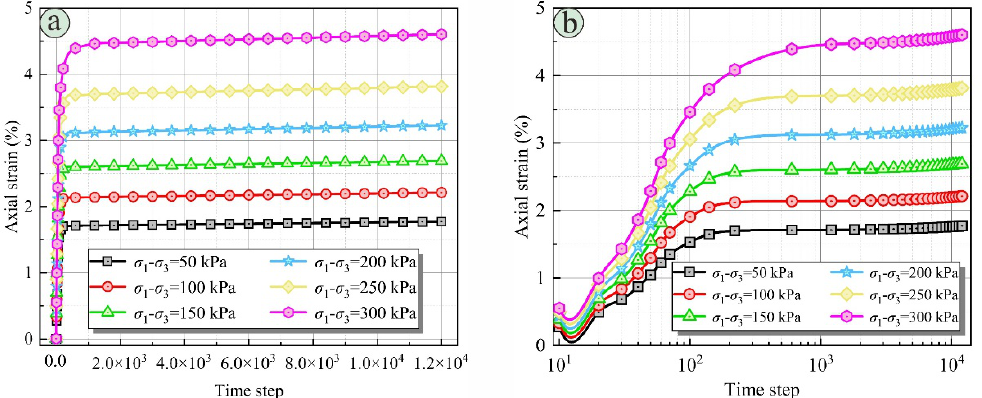
Figure 9. Variation of axial strain with time step: ( a ) Axial strain time step curve under different deviatoric stresses; ( b ) Axial strain time step semi logarithmic curve under different deviatoric stresses.